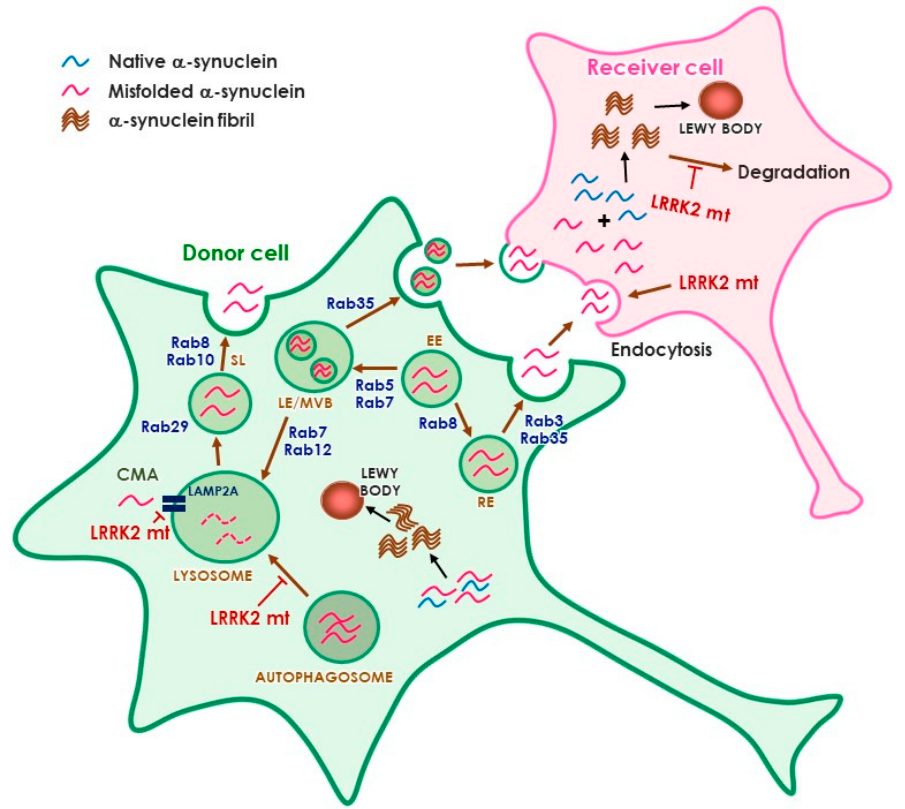
Figure 1. Potential role of LRRK2 in α -synuclein propagation. The cell may refer to neurons and/or glia. Abbreviations: EE, early endosome; LE, late endosome, MVB, multivesicular body, RE, recycling endosome, SL, stress lysosome, CMA, chaperone-mediated autophagy.